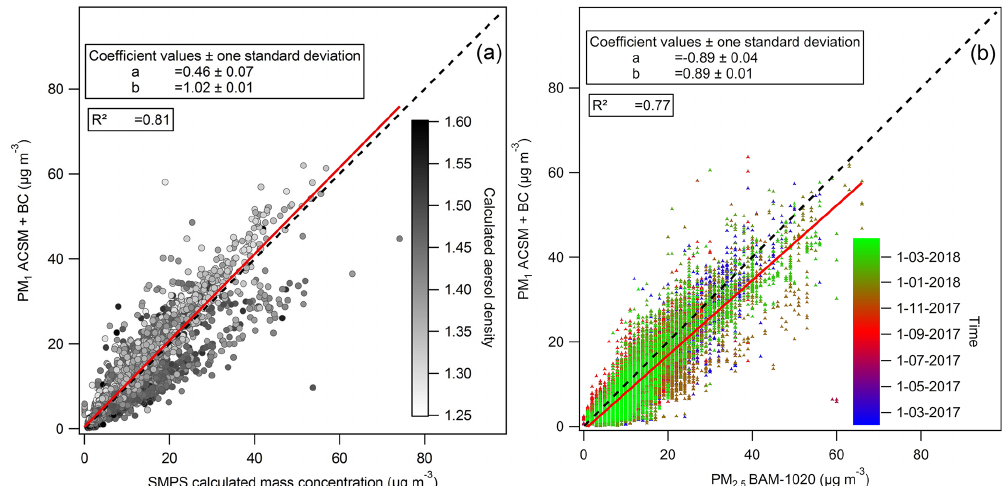
Figure 2. Reconstructed PM 1 (ACSM + BC) vs. PM 1 calculated from SMPS measurements, with the colour-coded density evaluated from the PM 1 chemical composition (a) and reconstructed PM 1 vs. PM 2 . 5 measurements by BAM-1020, coloured according to the sampling time (dd-mm-yyyy) (b) . Red lines correspond to orthogonal distance fits and black dashed lines to 1 : 1 lines. R 2 are determined with least square fits. Table 1. Seasonal average concentrations and associated standard deviation (SD) of the main chemical species of submicron aerosol and specific organic fragments for the study period. Average concentrations and SD of BC, nitrate, and particle number (20–100nm) components are also represented. Spring